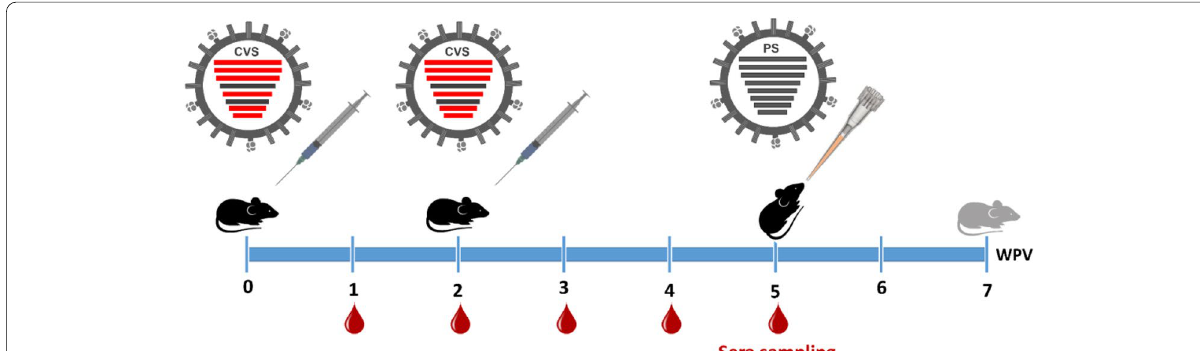
Fig. 2 The experimental timeline includes initial immunostimulation, booster vaccination, and challenge infection of immunized mice for up to 7 weeks post-vaccination (WPV). Eight-week-old black/6 mice were immunized at zero time of the experiment, followed by a booster vaccination at week 2 post-initial immunization to stimulate neutralizing antibodies against candidate vaccine strain (CVS) in mice. Challenge infection of immunized mice with the parent strains (PS) was done at week 5 post-vaccination and followed up for 2 weeks